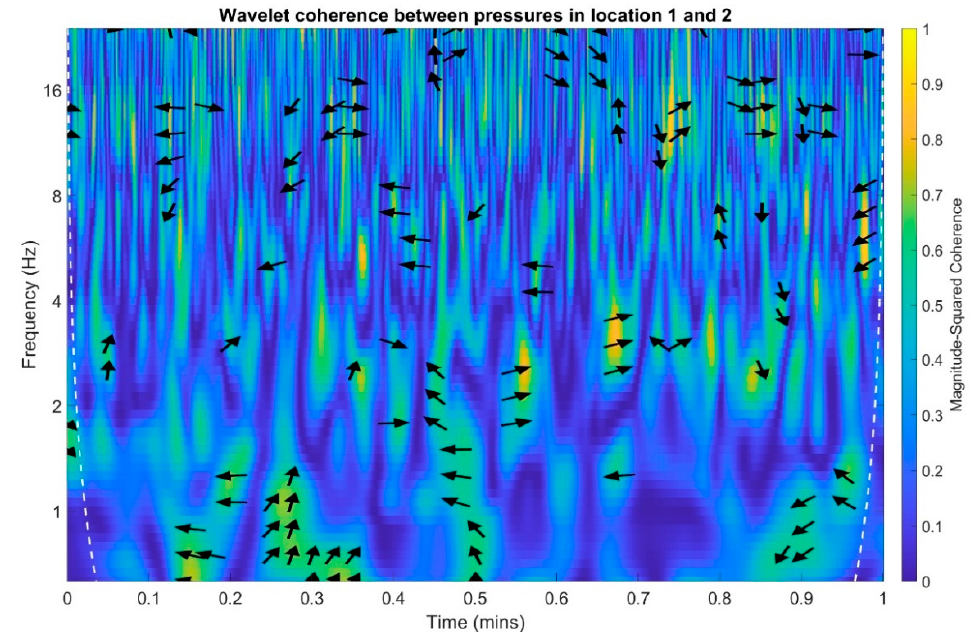
Figure 23. Wavelet coherence between acoustic pressures of infrasound measured in locations 1 and 2.